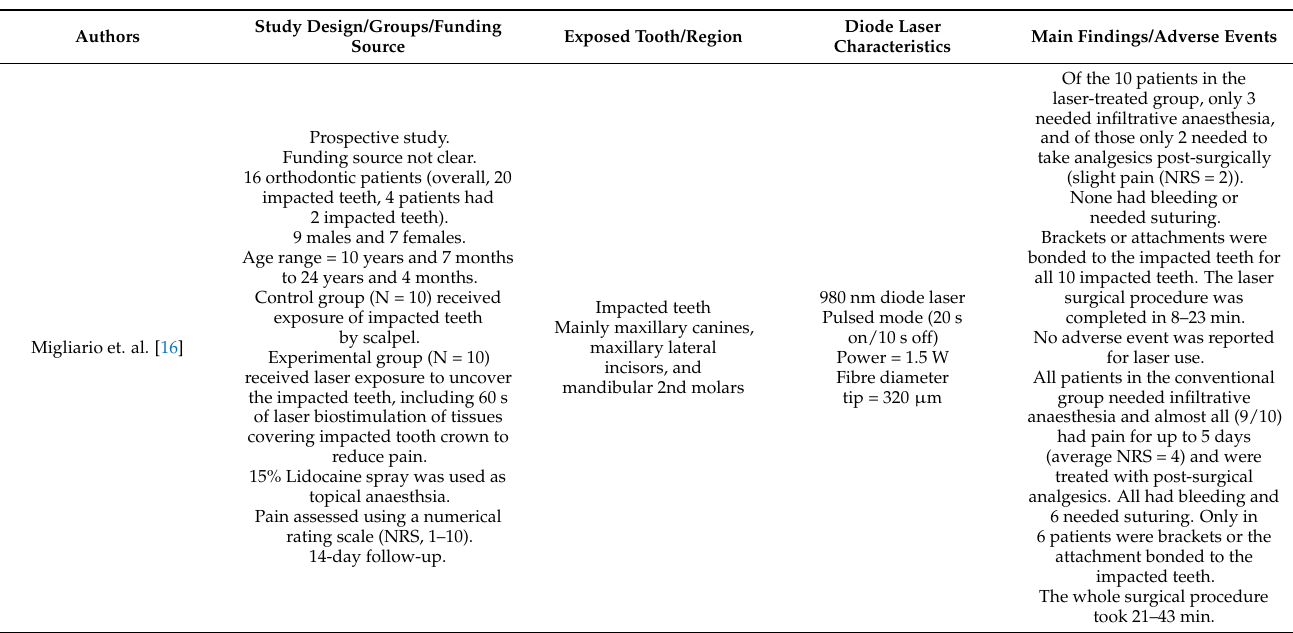
Table 1. Summary of identified evidence comparing diode laser surgical exposure with conventional scalpel surgical